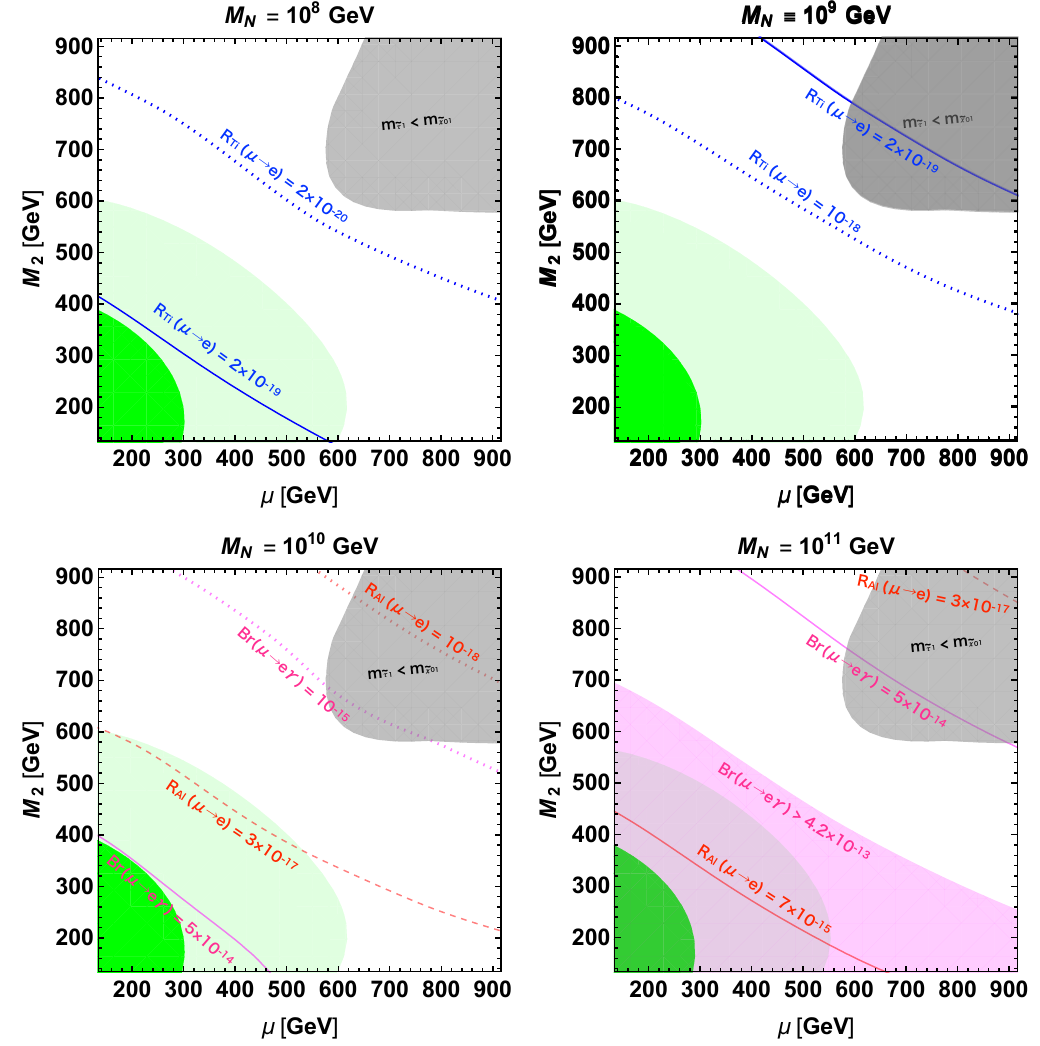
Figure 2 . Contours of the muon g − 2 and LFVs in the model A with the degenerated RH neutrinos. We take M 1 = 3 TeV, M 3 = 2 . 5 TeV, m A = 3 . 4 TeV, A u = − 1 TeV and tan β = 20 . In the dark (light) green regions, the muon g − 2 is explained at 1 σ level (2 σ level). The purple shaded regions are excluded due to too large Br( µ → eγ ) . The stau becomes the LSP in the gray shaded region.